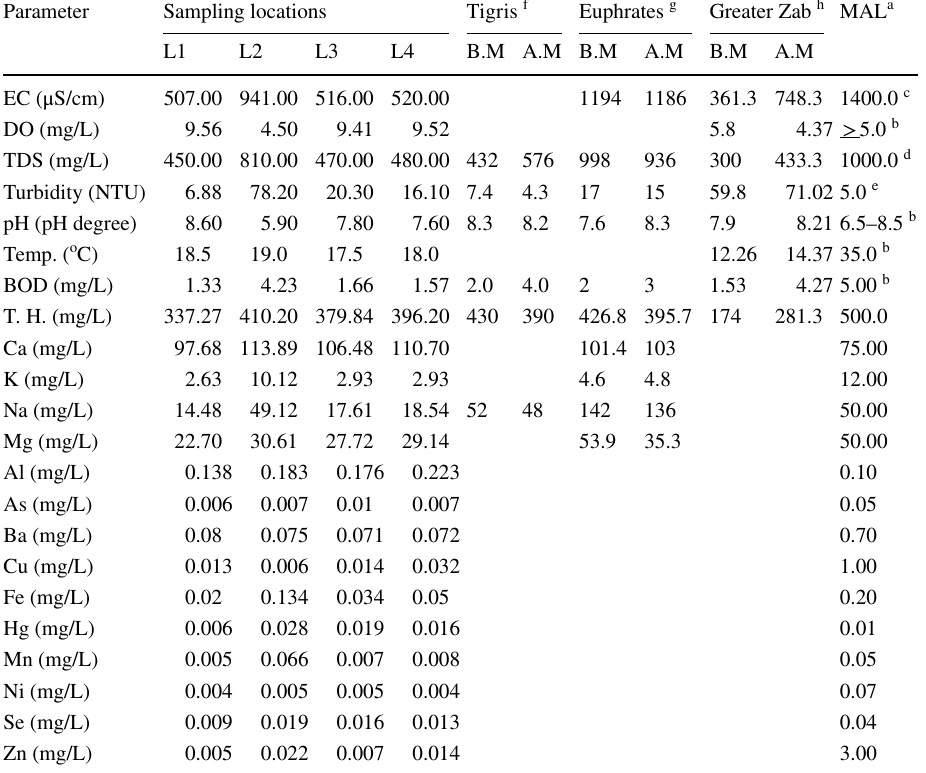
Table 1 Average data of physicochemical and heavy metals parameters for Diyala- Sirwan river and impact points of the Kalar city wastewater discharge compared with results of other Iraqi